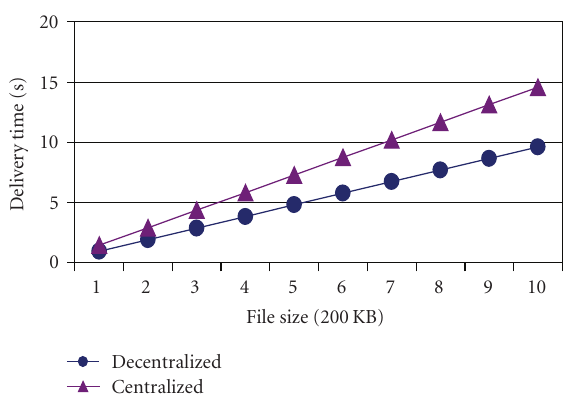
Figure 10: Data delivery time versus file size. (Bandwidth = 5.5 Mbps, three services are considered.)